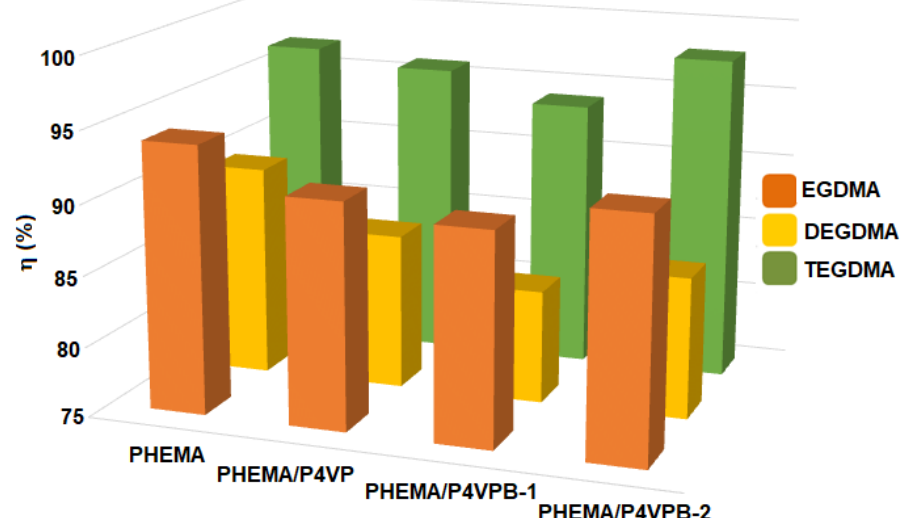
Figure 2. The influence of the chemical structure of the cross-linking agent on η (C 0 = 10%, C i = 2%, crosslinker: HEMA ratio = 1:20 (mol/mol), HEMA:linear polymer = 1:0.2 (g/g), T = 50 °C, t = 8 h, the solvent used to dissolve the synthetic polymers was ethanol:sodium bicarbonate (40:60, v / v ).